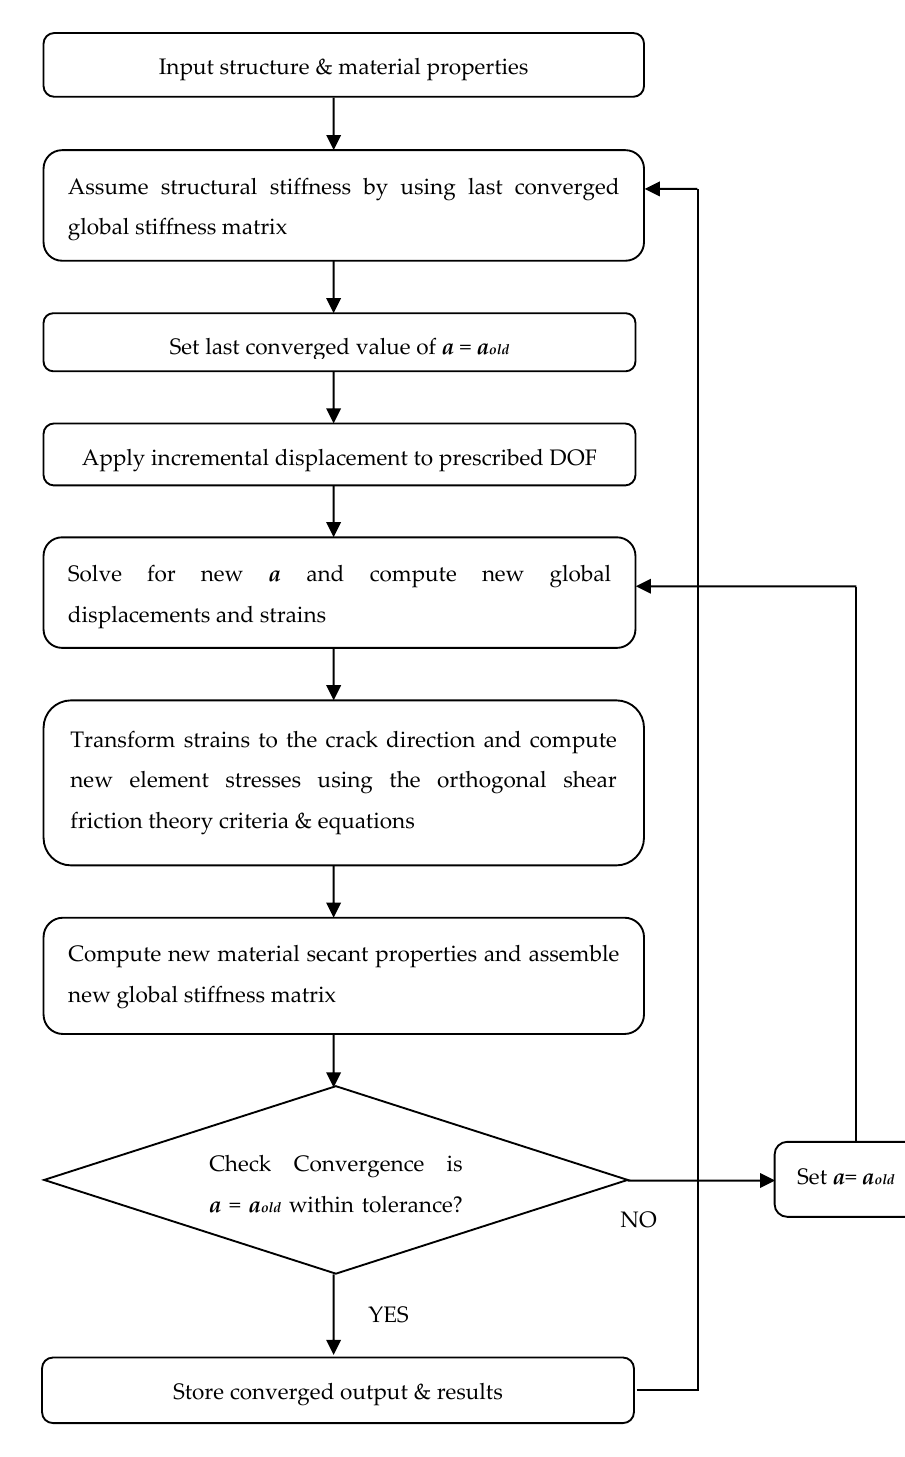
Figure 8. Flowchart of the PLV algorithm.